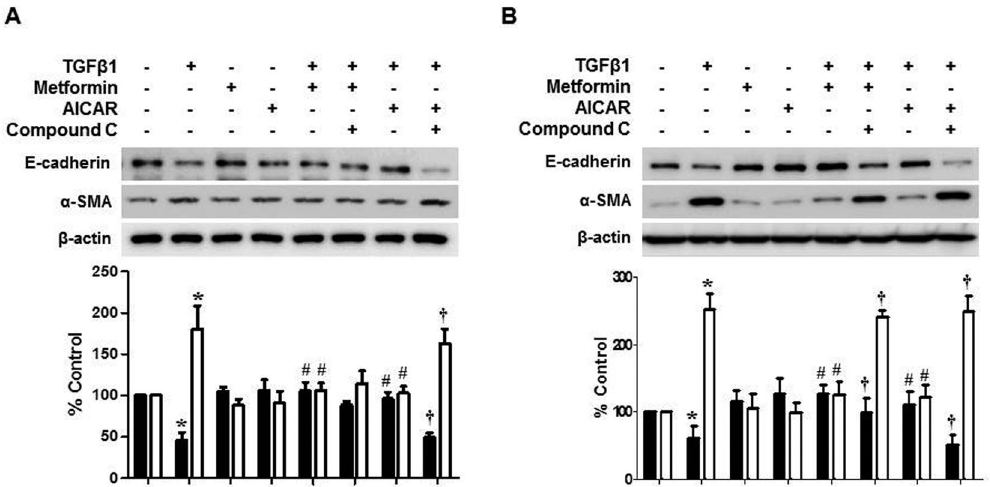
Figure 7. Differential Effect of Compound C on Metformin- and AICAR-induced Amelioration of EMT. Compound C, AMPK inhibitor, dose not reverse the protective effect of metformin on TGF- β 1-induced EMT at 12 hours ( A ), but partially inhibits the effect of metformin at 48 hours of TGF- β 1 stimulation ( B ). Effect of AICAR on TGF- β 1-induced EMT is blocked by compound C at 12 ( A ) and 48 hours ( B ). N = 4. * p < 0.05 vs. others, # p < 0.05 vs. TGF- β 1, † p < 0.05 vs. TGF- β 1 + AICAR or